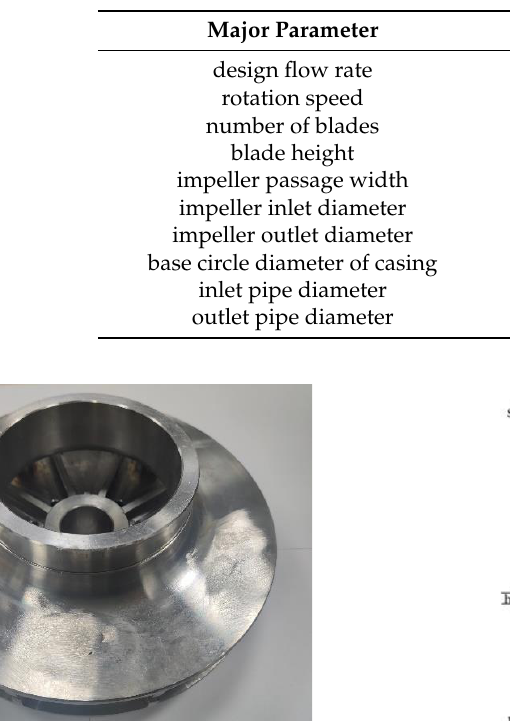
Table 1. Main parameters of disc pump with Radial Straight Blade.